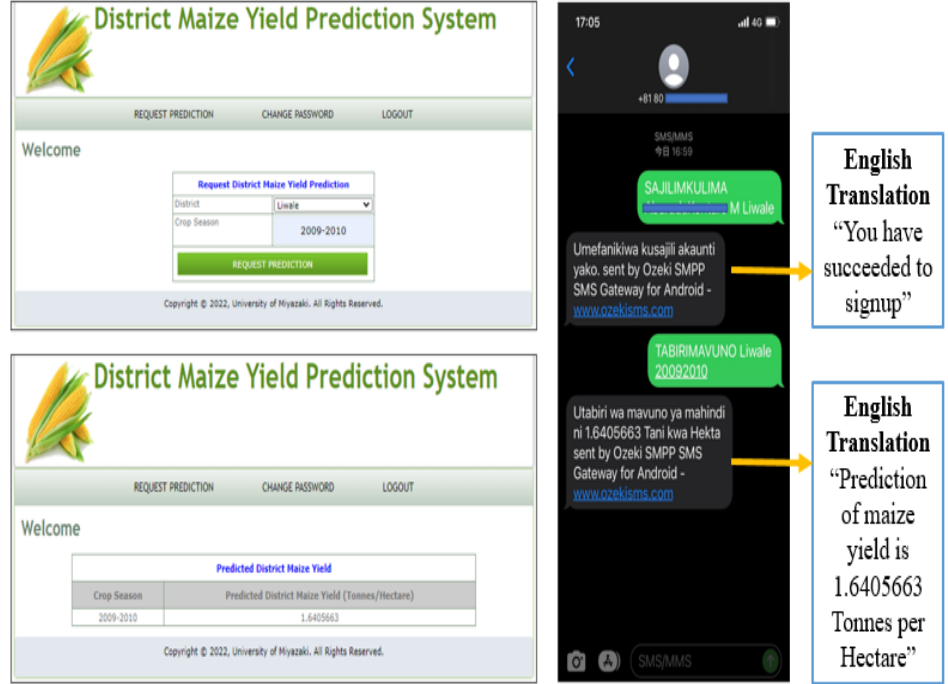
Figure 12. Top left : Ministry officer requests Liwale district end-of-season maize yield in the Web system. Bottom left : Requested maize yields displayed in the Web system. Right : Farmer signs up and requests and receives Liwale district end-of-season maize yields in Swahili.